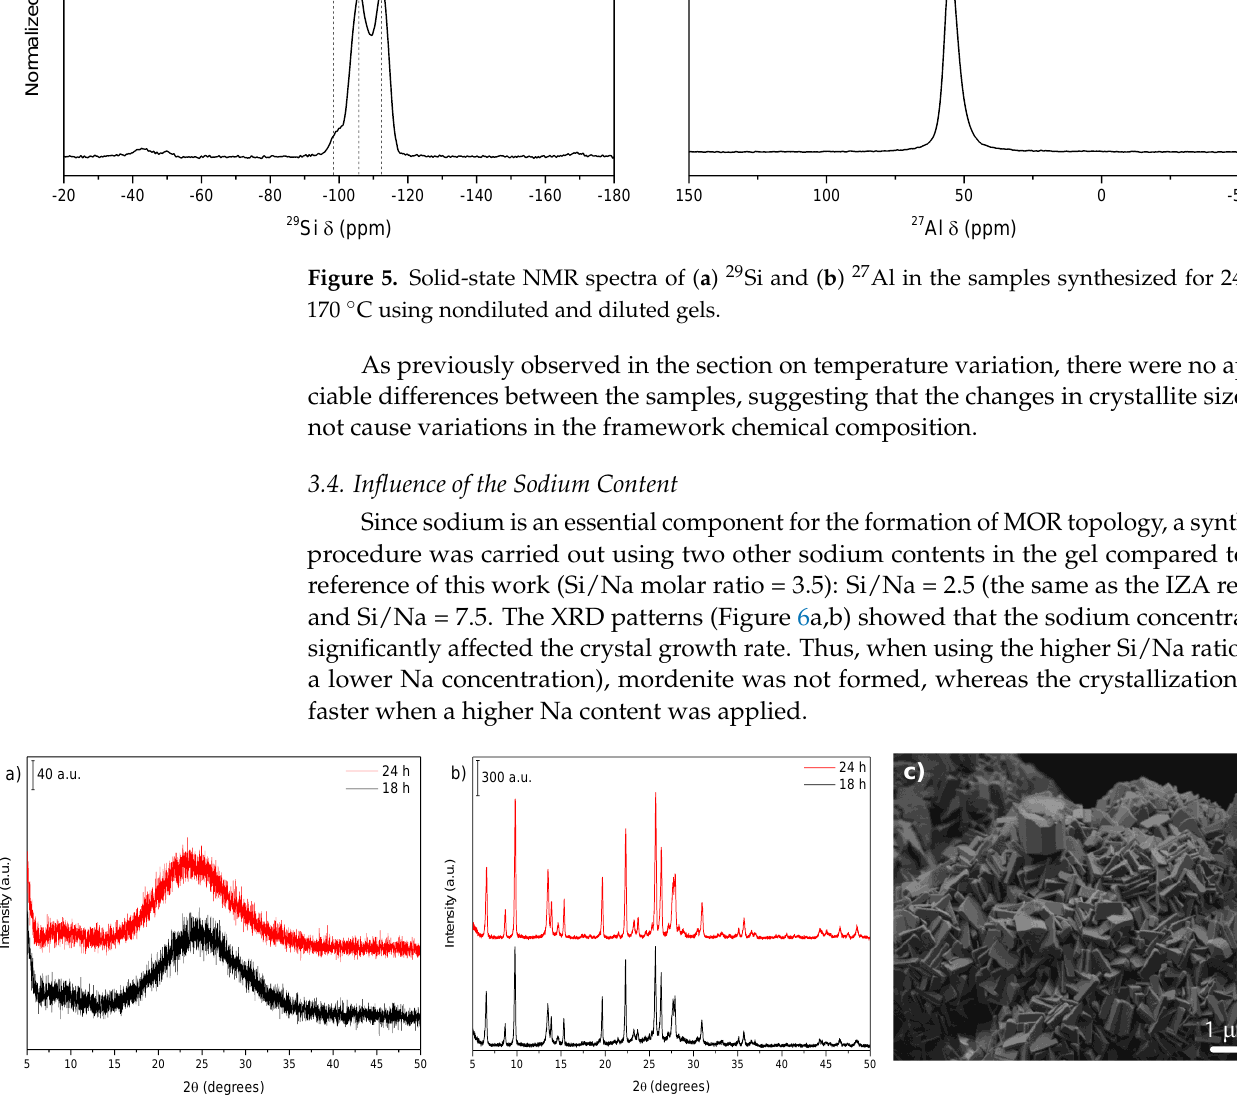
Figure 6. XRD patterns of samples synthesized using ( a ) Si/Na molar ratio of 7.5 and ( b ) Si/Na molar ratio of 2.5, and ( c ) SEM image of the sample prepared for 24 h using Si/Na = 2.5.